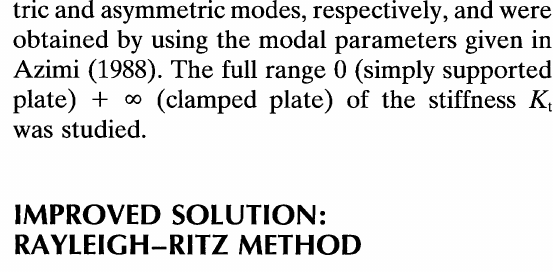
plate is welded to a circular cylindrical shell.